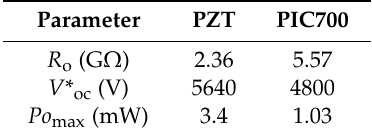
Table 3. Parameters of the piezoelectric energy harvesting application